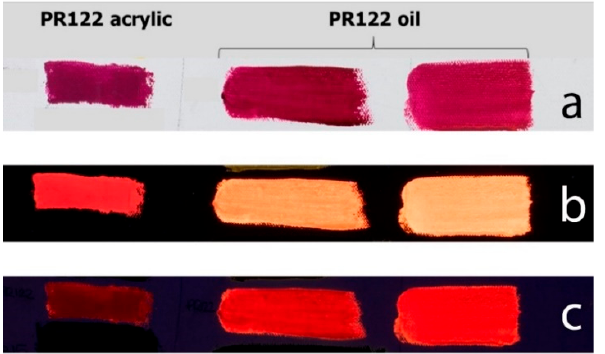
Figure 9. ( a ) Visible image of painting layers on canvas containing quinacridone magenta PR122 in acrylic resin and in linseed oil. For the latter binder, two slightly different concentrations of the pigment were used, decreasing from left to right; ( b ) UVF image; ( c ) VIVF image.